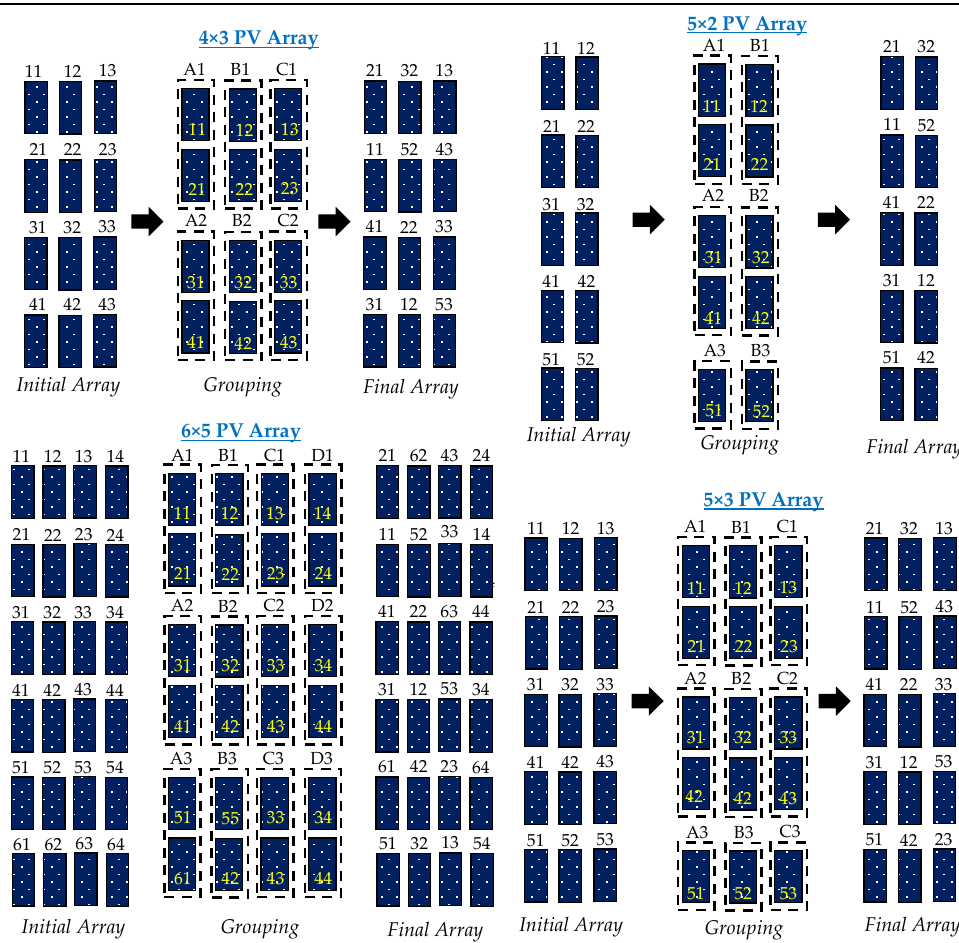
Figure 5. Application of the proposed two-step approach in arbitrary PV array sizes.